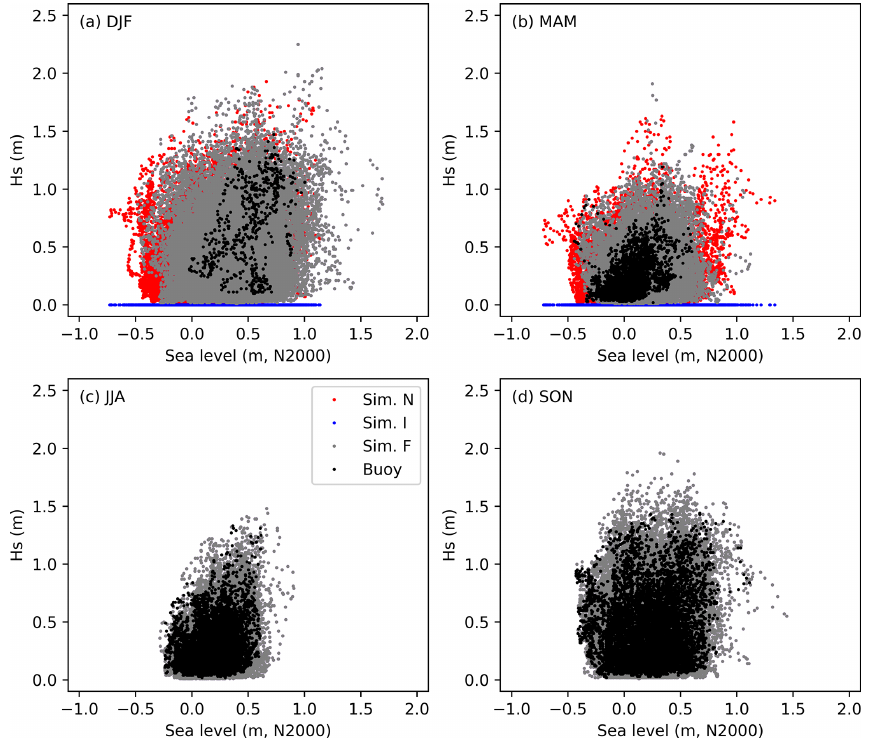
Figure 4. Scatter plots of (a) winter, (b) spring, (c) summer, and (d) autumn events. Black: observed wave heights from 2016 to 2019. Other colours: simulated wave heights from 1992 to 2019; ice types F (grey), I (blue), and N